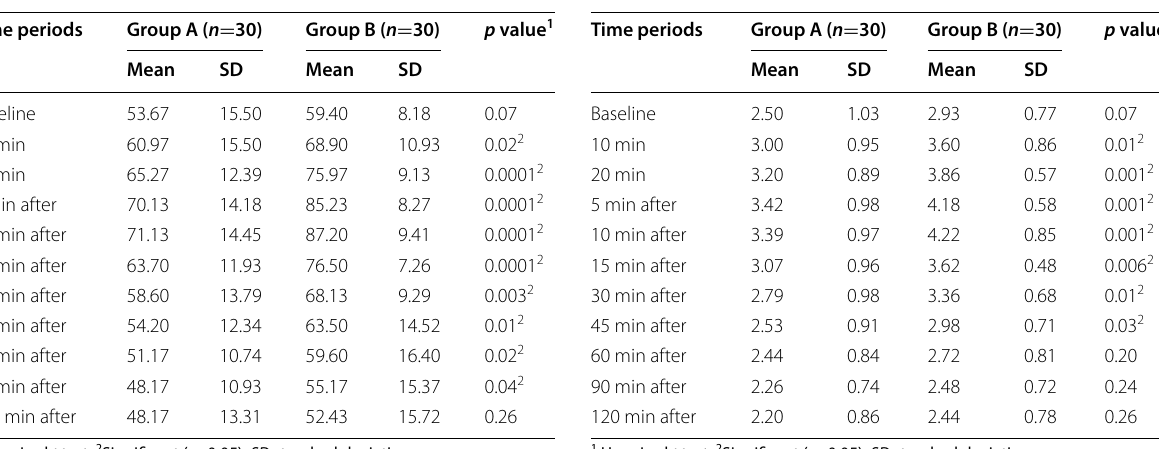
Table 5 Comparison of cardiac index (CI) between the groups